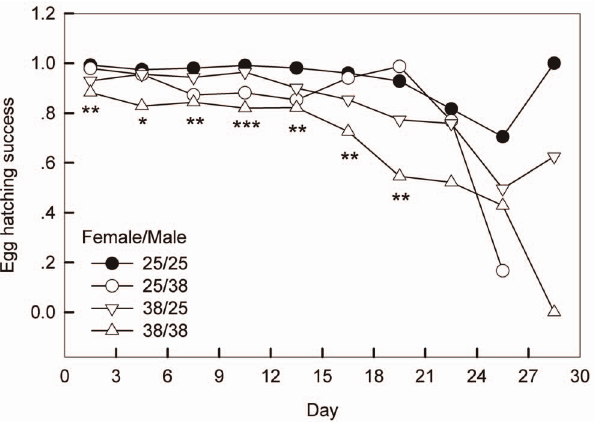
Fig. 3. Impact of heat stress on egg hatching success every three days across the whole oviposition period. Treatments involve different combinations of female and male treatment either at 25 ˚ C or 38 ˚ C for 4 h. 25/25: both males and females were kept at 25 ˚ C; 25/38: females were remained at 25 ˚ C but males stressed at 38 ˚ C; 38/25: females were stressed at 38 ˚ C and males were remained at 25 ˚ C; 38/38: females and males were stressed at 38 ˚ C. The asterisks below each plot indicate significant differences between treatments (* P , 0.05; ** P , 0.01, *** P , 0.001).